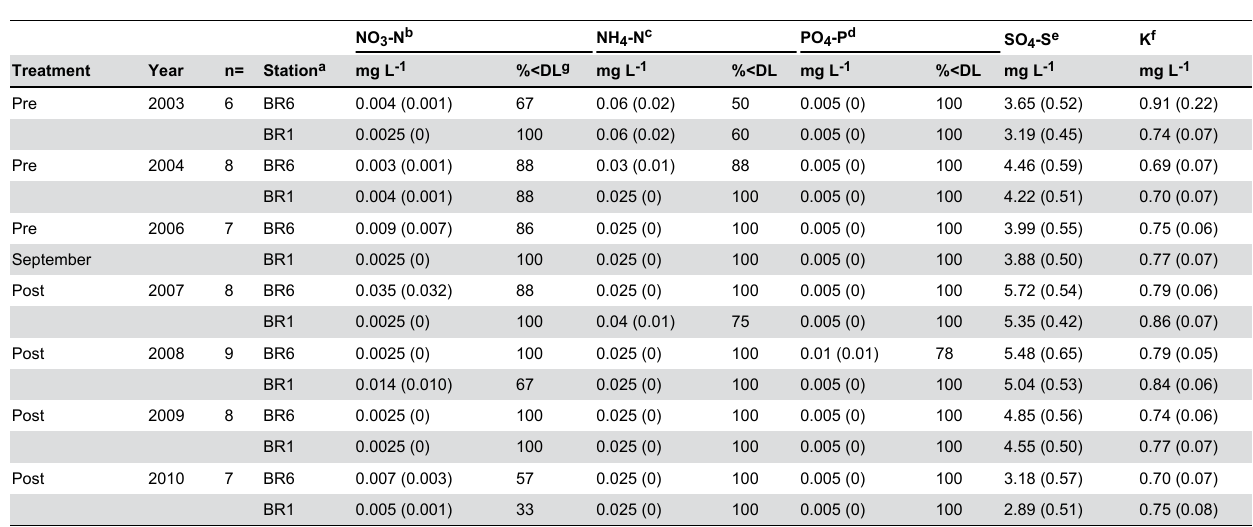
Table 7. Mean annual nutrient concentrations measured at Bailey